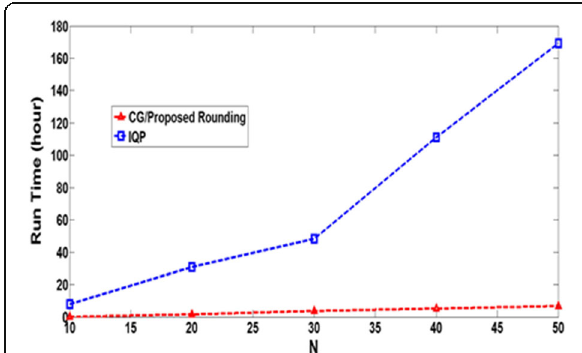
Fig. 13 Comparison of the run time between IQP and CG/proposed